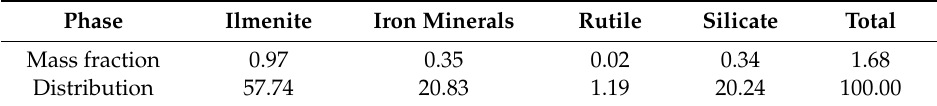
Table 4. Chemical phase analysis of titanium in raw sample (wt %).